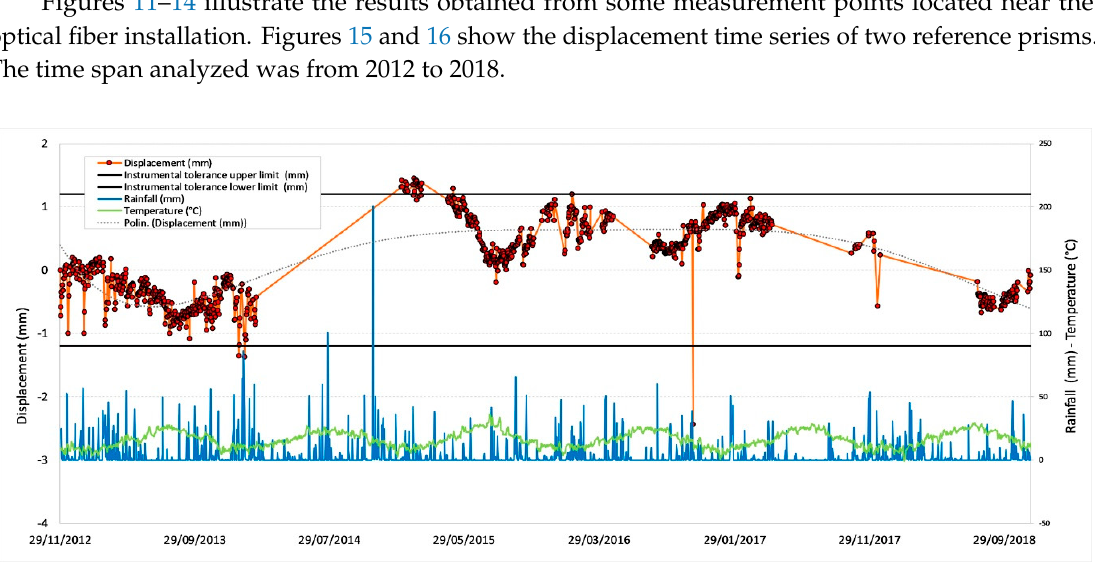
Figure 12. Displacement recorded by the RTS at the measurement point G15. Figure 13. Displacement recorded by the RTS at the measurement point G17.